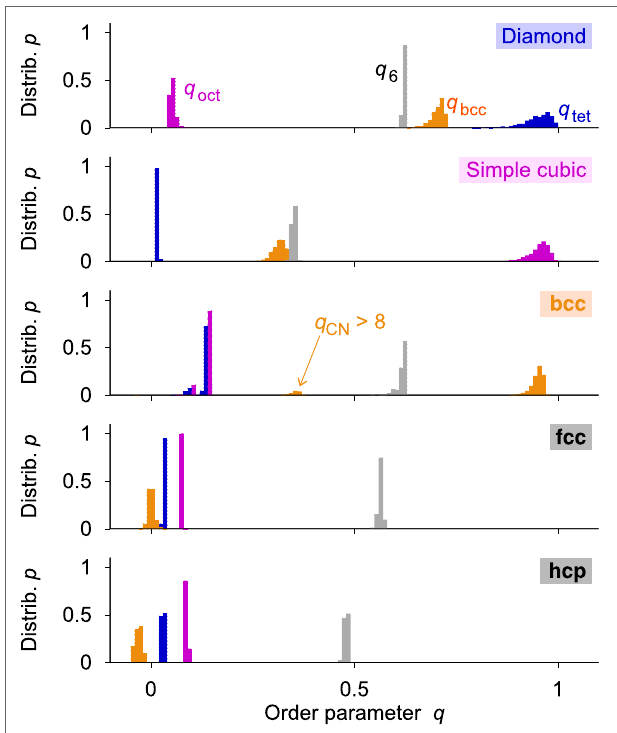
FIGURE 5 | Relative frequency distribution, p , of all four order parameters q tet , q oct , q bcc , and q 6 in all five prototype structures diamond, cubic, bcc, fcc, and hcp when the positions of atoms are subject to Einstein crystal-like perturbations away from their ideal location (here: Gaussian width of perturbations σ ES / d id = 0.02, and cutoff radius for neighbor finding relative to the ideal neighbor distance in the perfect prototype structure r cut / d id = 1.1). Note that the small intermediate peak at q bcc = 0.35 obtained with the bcc prototype structure (central panel) is caused by configurations that have a non-ideal number of neighbors ( q CN > 8)—not by the order parameter definition itself.